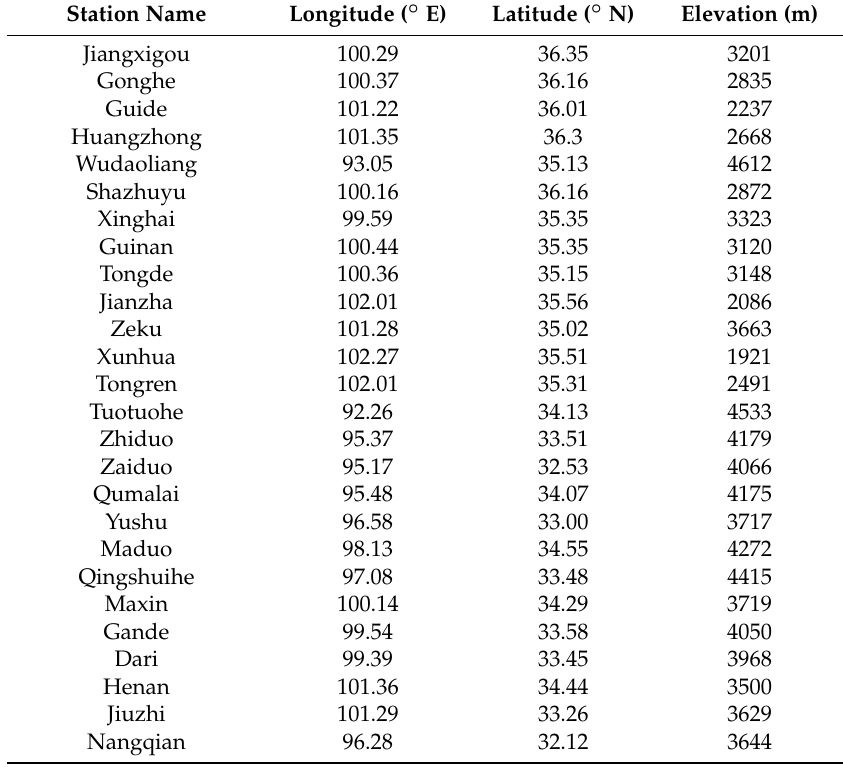
Table 1. General information on the meteorological stations in the